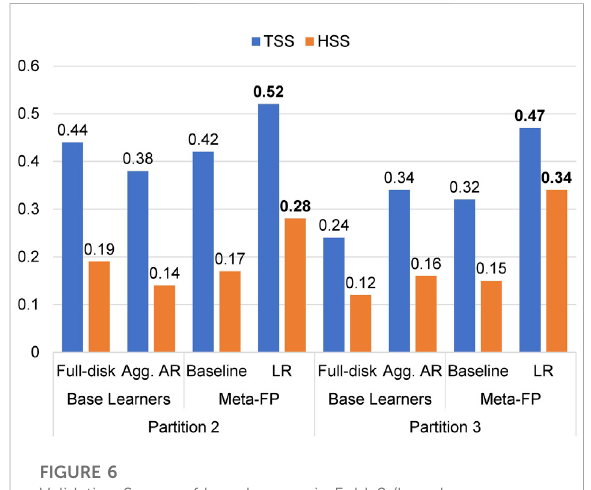
FIGURE 6 Validation Scores of base learners in Fold-2 (base learners trained with Partitions 1 and 4) and the corresponding validation scores of Meta-FP (meta models trained in Expt. 2).